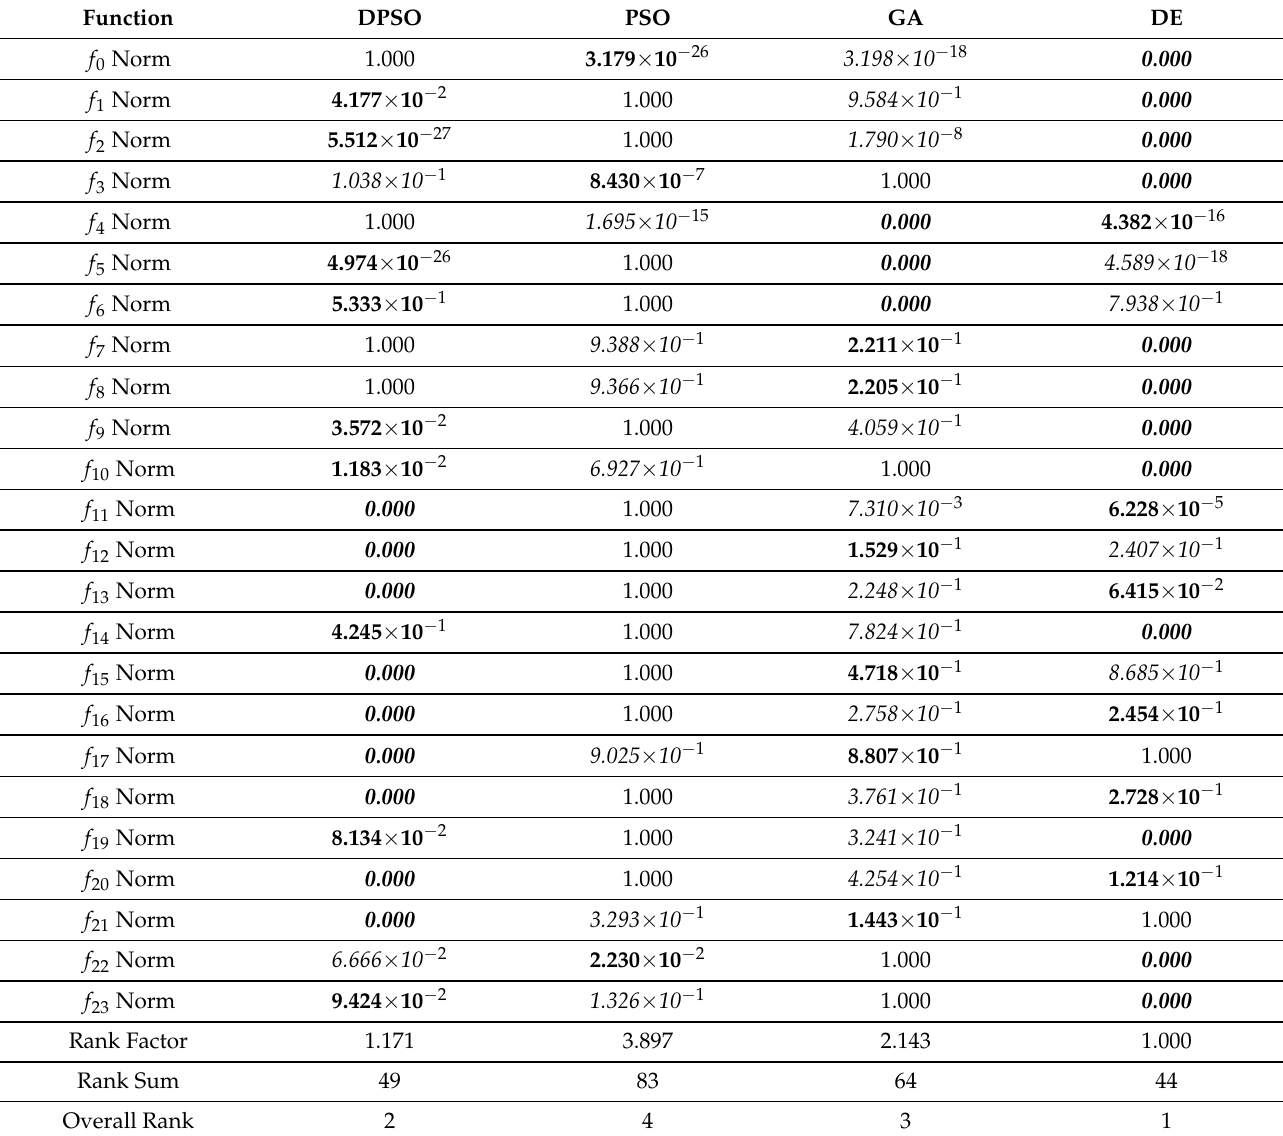
Table 3. Normalized fitness w.r.t. each function problem with 14 dimensions and the resulting ranking: rank 1 (best) , rank 2 , rank 3 , and rank